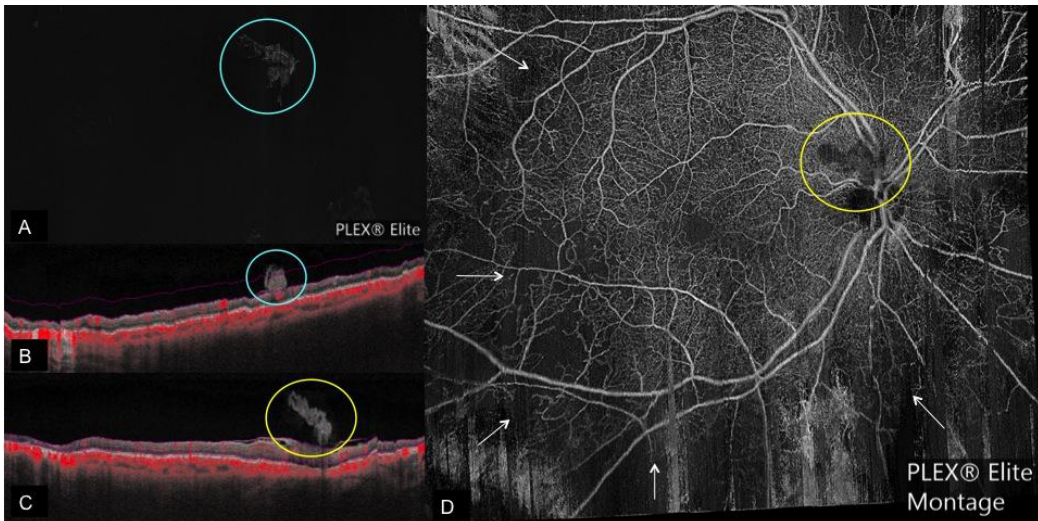
Figure 2. Regressed neovascularization on OCTA. ( A ): Regressed neovascular lesion (blue circle) seen on vitreous segmentation on en face OCTA with the corresponding cross-sectional OCTA. ( B ) Showing the regressed neovascular lesion with patchy area of flow (indicated by red color) extending from the retina surface into the vitreous; pink lines on B depict the boundaries of vitreous segmentation; ( C ): Cross-sectional OCTA image of a regressed neovascular lesion of the disc with no flow (yellow circle) corresponding to the en-face OCTA Montage; ( D ): Showing the regressed neovascularization of the disc with no flow (yellow circle) and flow voids (white arrows) after panretinal photocoagulation.